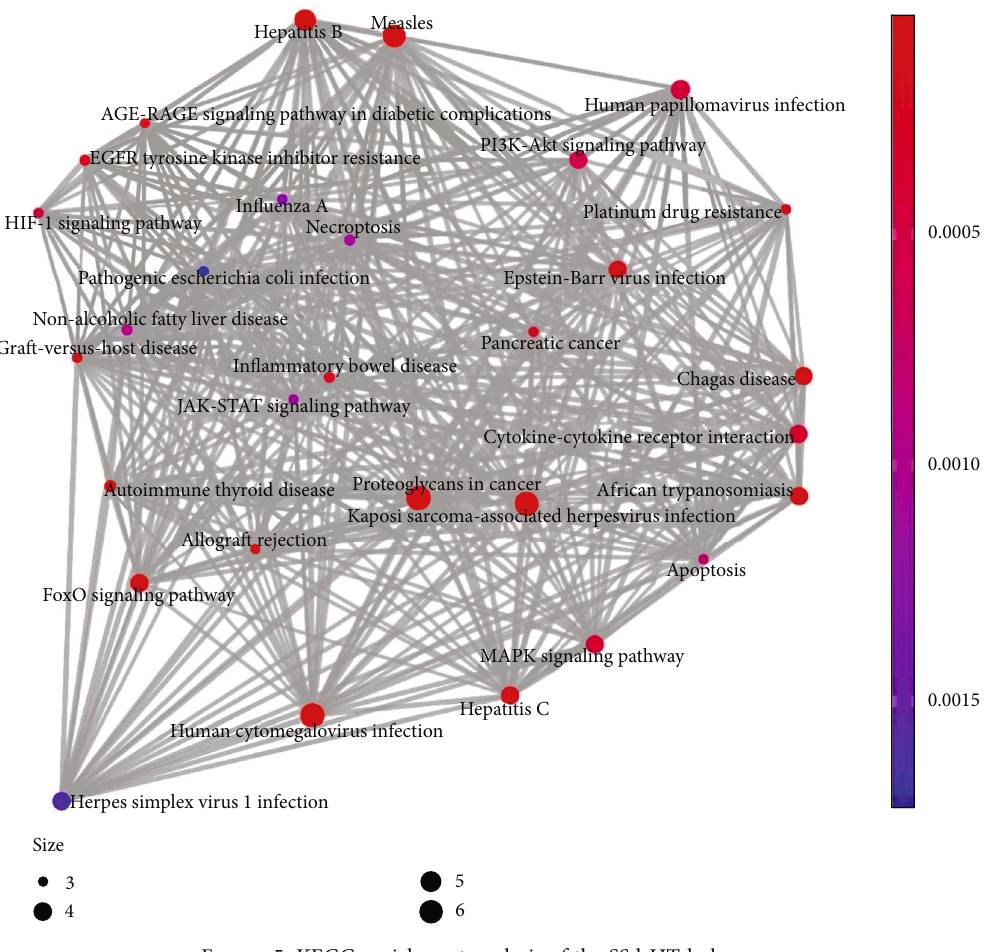
Figure 5: KEGG enrichment analysis of the SSd-HT hub gene. Table 5: Serum TPOAb, TgAb, and TSH concentrations in mice ( mean ± SD